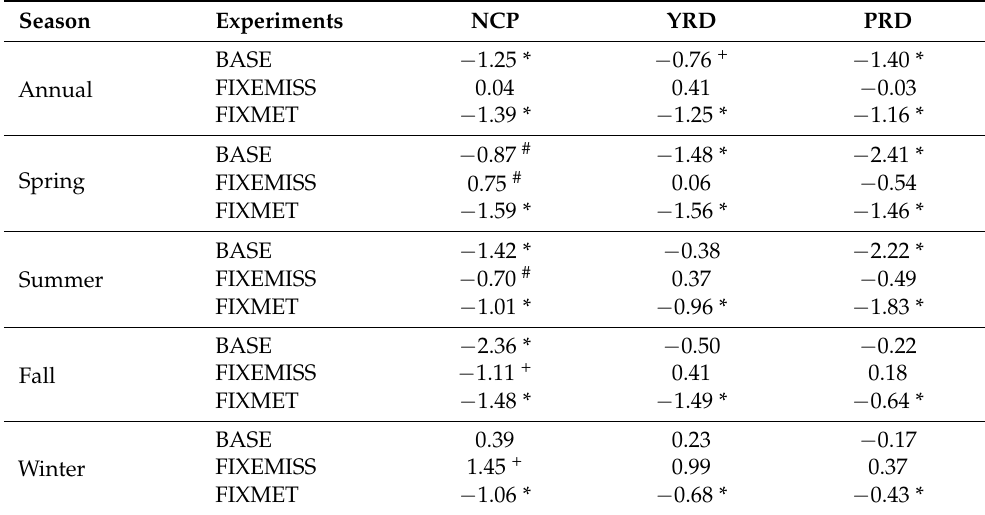
Table 1. GEOS-Chem simulated trends of PM 2.5 /AOD ratios ( η , µ g m − 3 year − 1 ) in 2006–2017 in NCP, YRD and PRD.